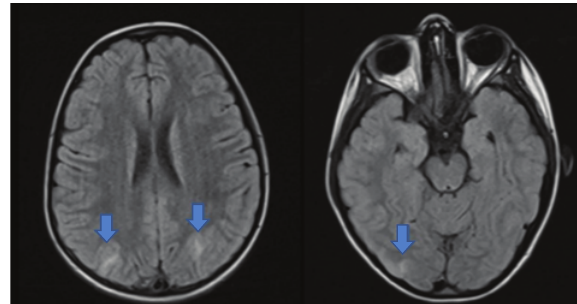
Figure 1: MRI Axial T2-Flair image. A six-years girl with HSP complicated by PRESS. Bilateral hyperintense lesions of subcortical white matter in the occipital region.